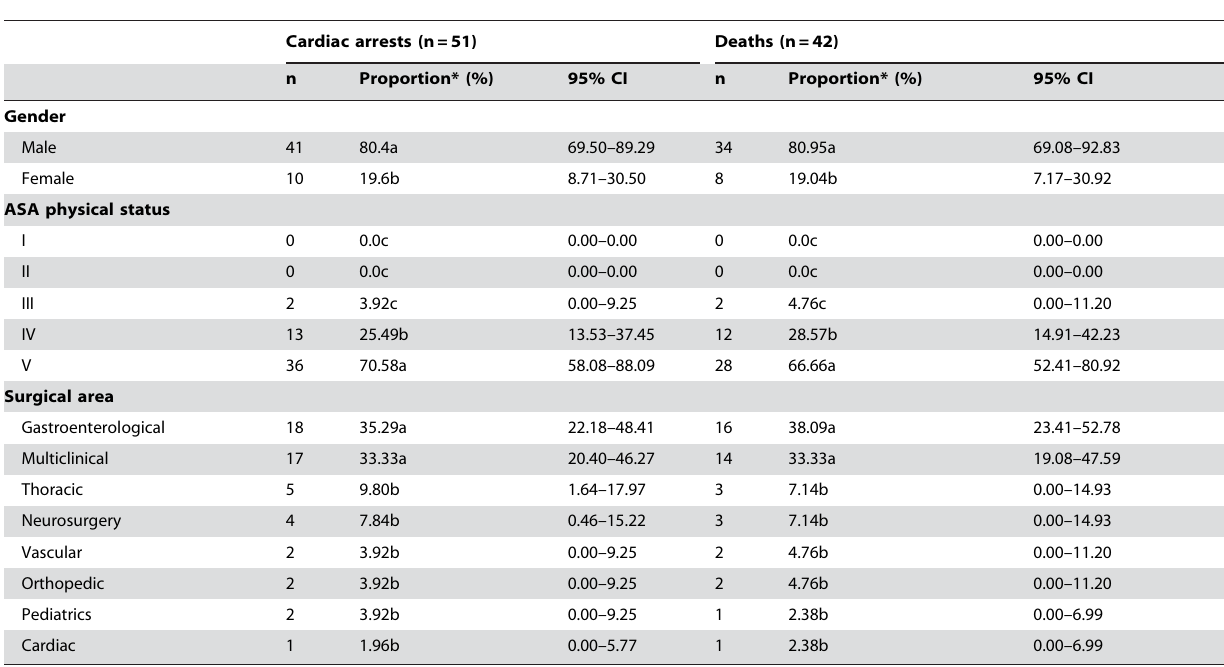
Table 2. Intraoperative cardiac arrest and mortality proportions in trauma patients, grouped by gender, ASA physical status and surgical area.